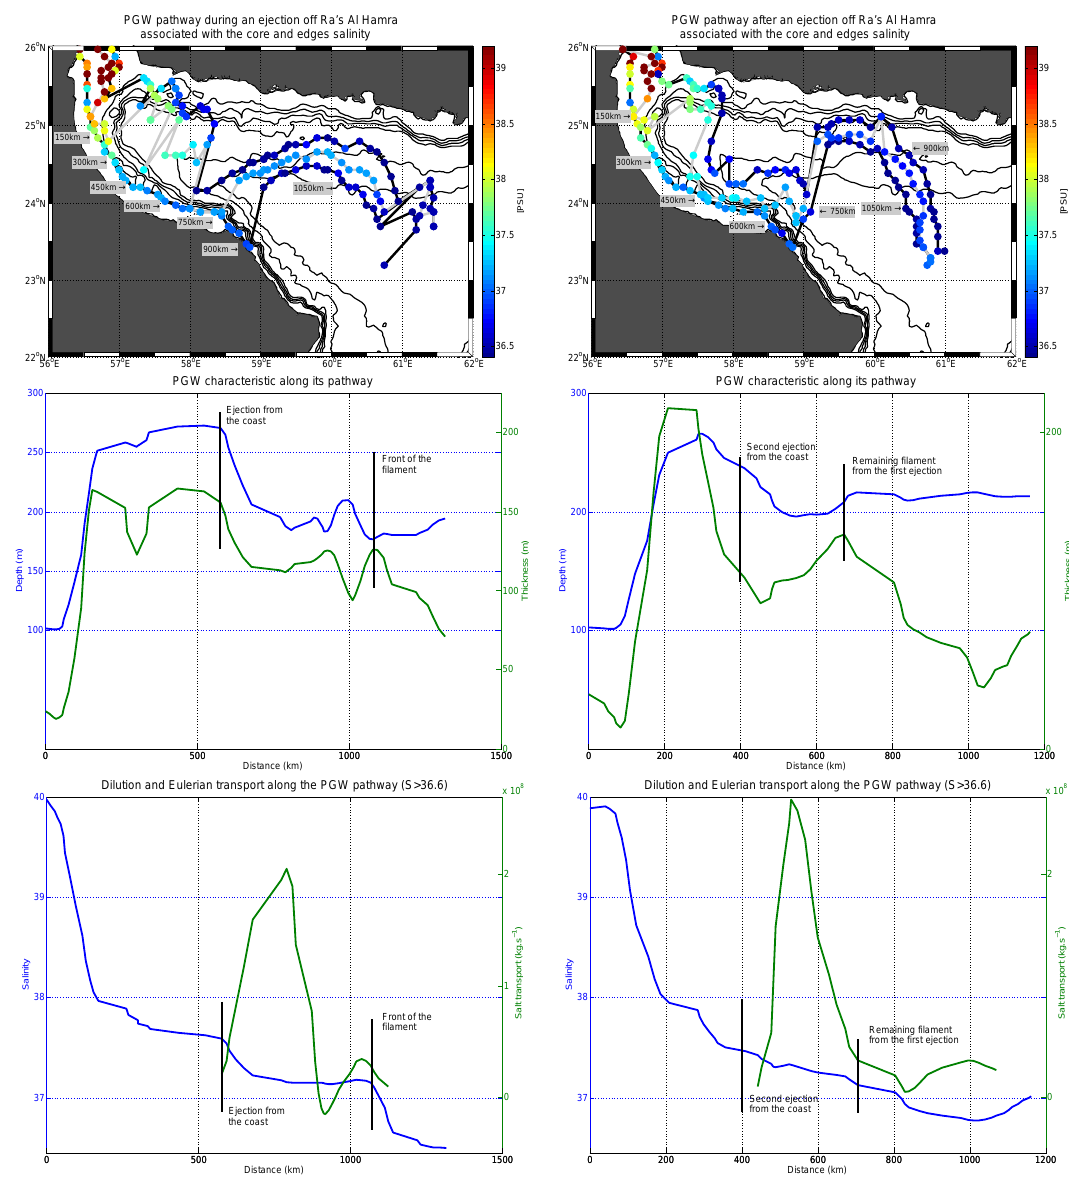
Figure 22. Evolution of the PGW characteristics during the ejection off Ra’s Al Hamra (on 23 May, left) and after (on 4 June, right). The first row shows the pathway of the maximal salinity of PGW and the width of the outflow. The second row displays the depth and thickness of the outflow and the third row maximal salinity and transport of salt along the